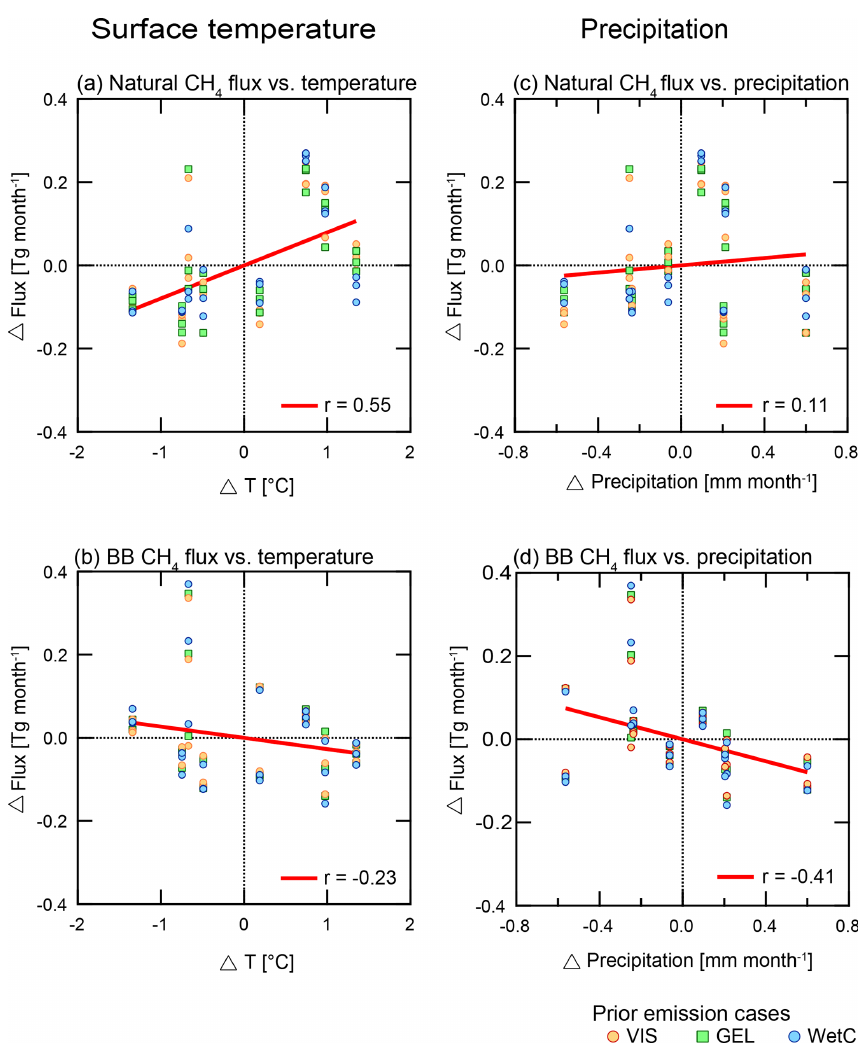
Figure 11. CH 4 flux anomalies vs. surface temperature and precipitation anomalies for summer (July and August). The CH 4 fluxes are July and August posterior fluxes for Northwest Territories (NT) from nine inversion experiments with mask A. Regional climate parameter anomalies in NT are monthly deviations from the 4-year (2012–2015)